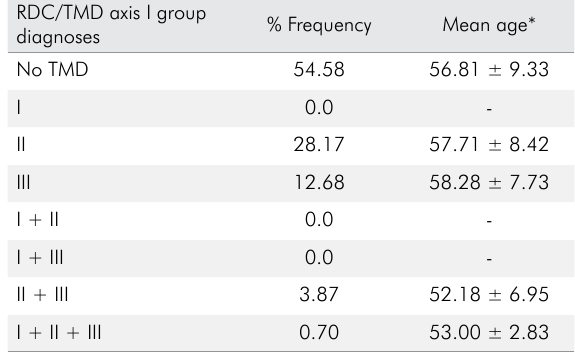
Table 2. Frequency and mean age of single and combined RDC/TMD axis I diagnoses in the study population.